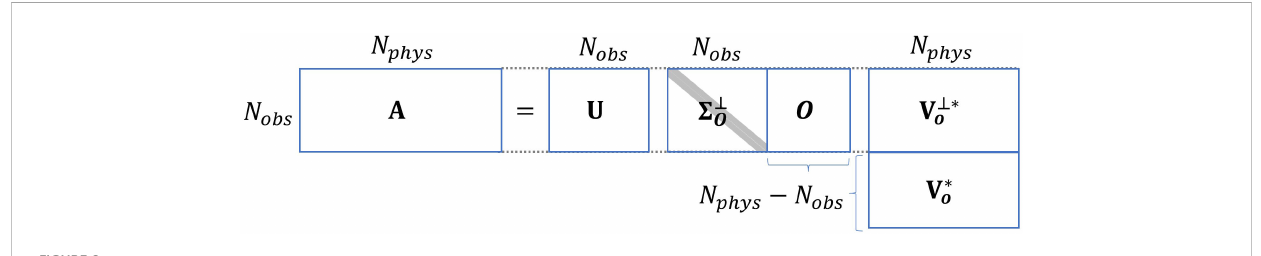
FIGURE 2 SVD of the Jacobian matrix A = U ∑ V*